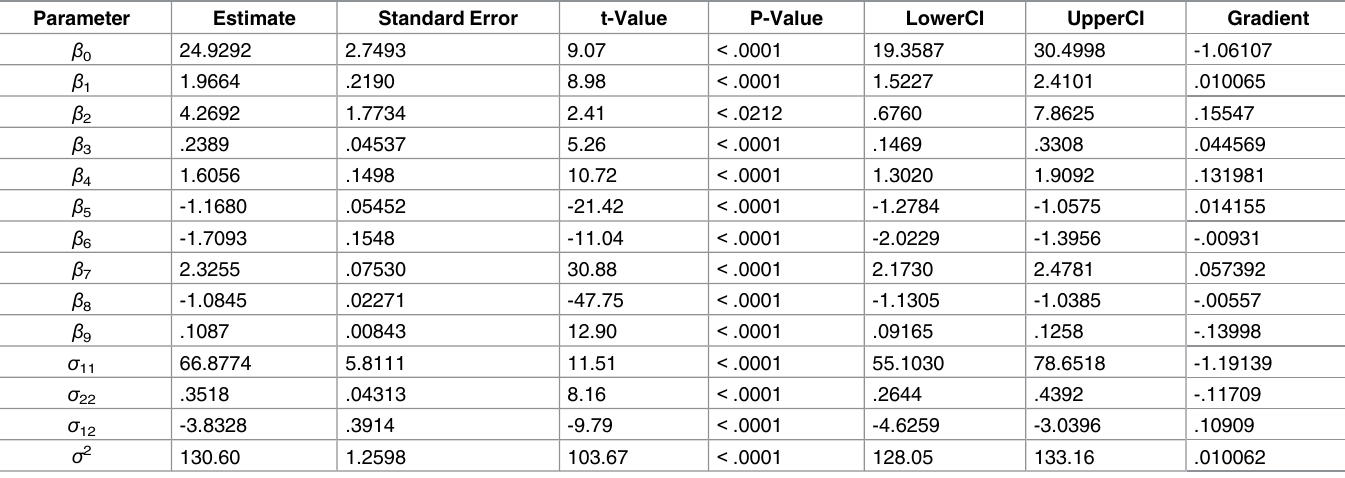
Table 1. Summary of model parameterestimates, standard errors, t-values, p-values, 95% confidence interval, and gradient. Parameter